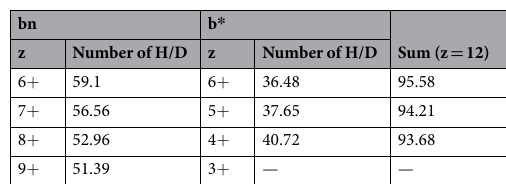
— Table 1. Deuterium distribution between bn and b * subunits after the fragmentation of the [bn-b * ] 12 + complex. Each row corresponds to an individual fragmentation channel so that the sum of charges is equal to 12. The average number of H/D exchanges in the isolated [bn-b * ] 12 + is 96. T = 300 °C. Symbol “—” indicates that the data is not